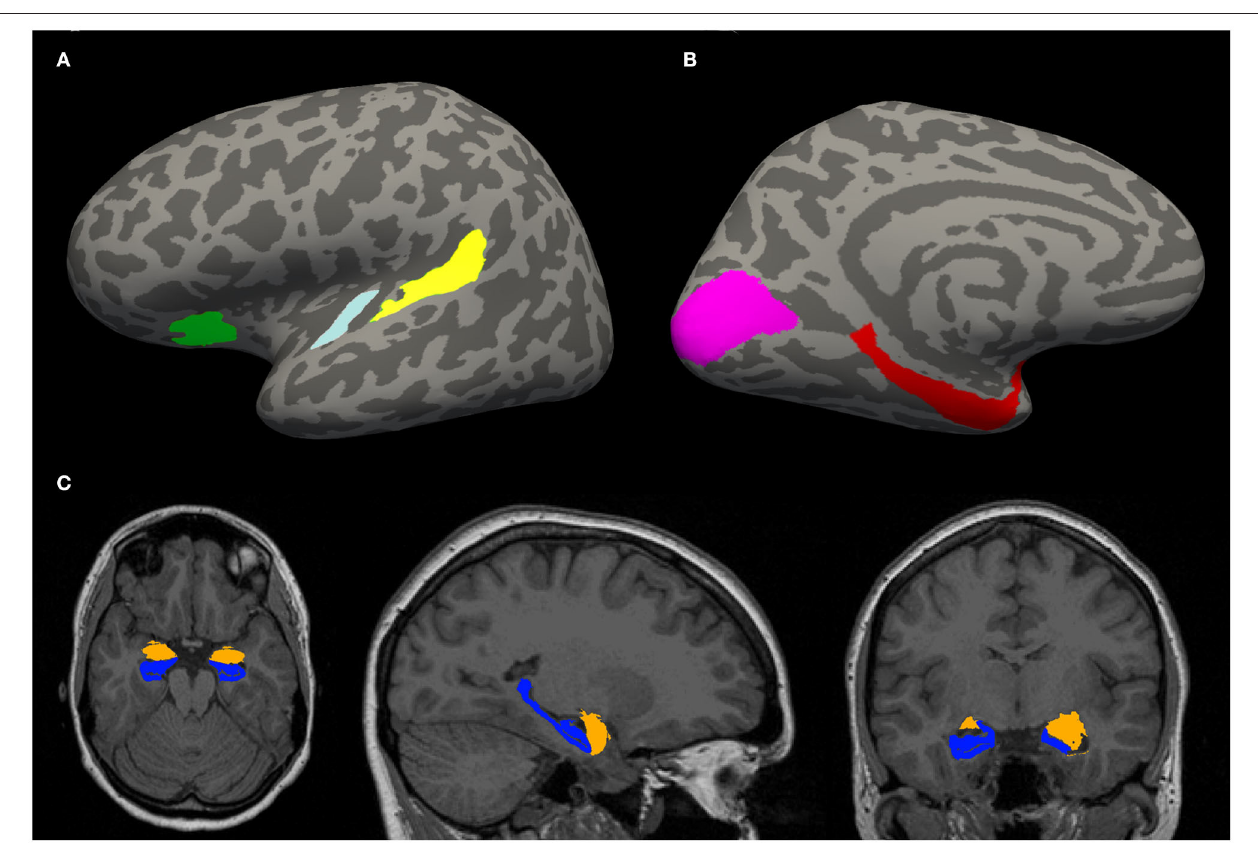
FIGURE 1 | (A,B) Example of an inflated cortical surface with colored regions of interest. These regions were chosen based on their relation with tinnitus in the literature. Yellow—planum temporale (PT), light blue—Heschl gyrus (HG), green—anterior insula (Ins) (A) , purple—visual cortex (V1), red—parahippocampus (PH) (B) . (C) Example of a localization of limbic structures: hippocampus (blue) and amygdala